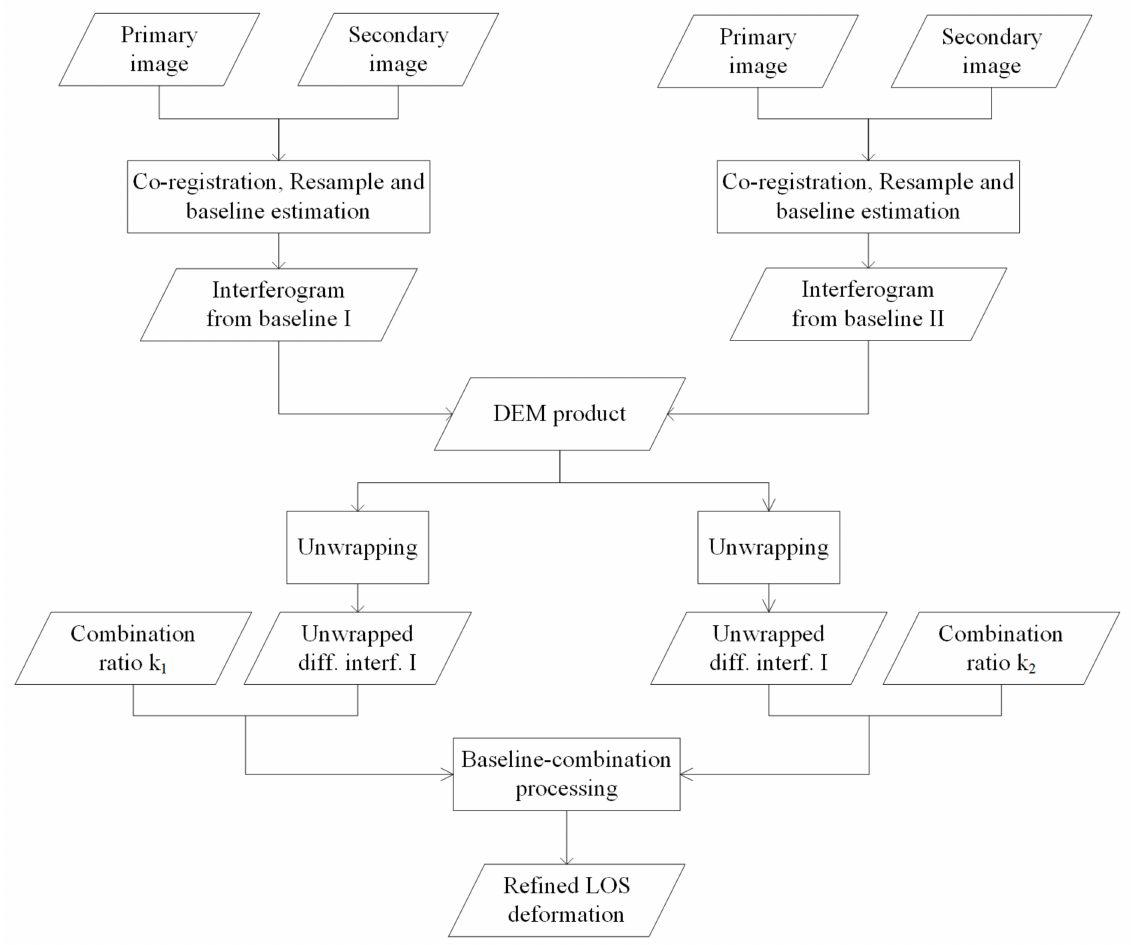
Figure 2. The workflow of the baseline-combination